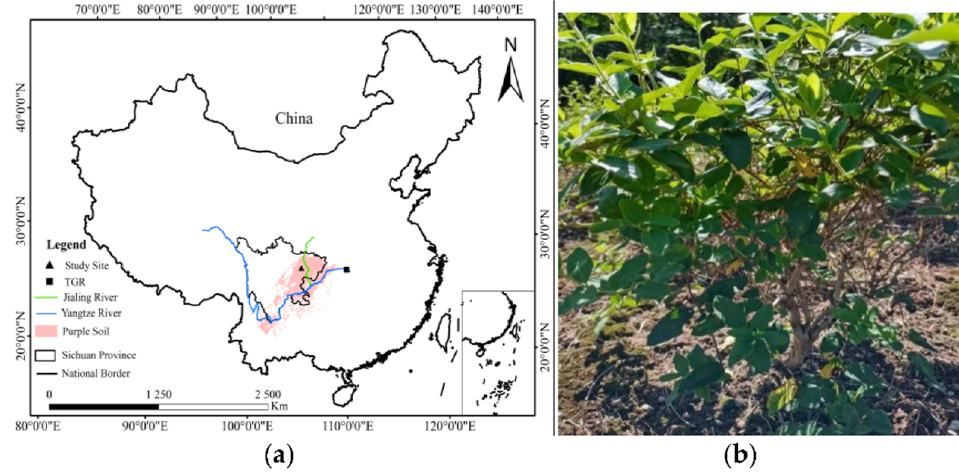
Figure 1. ( a ) Location of the study area and ( b ) actual view of honeysuckle